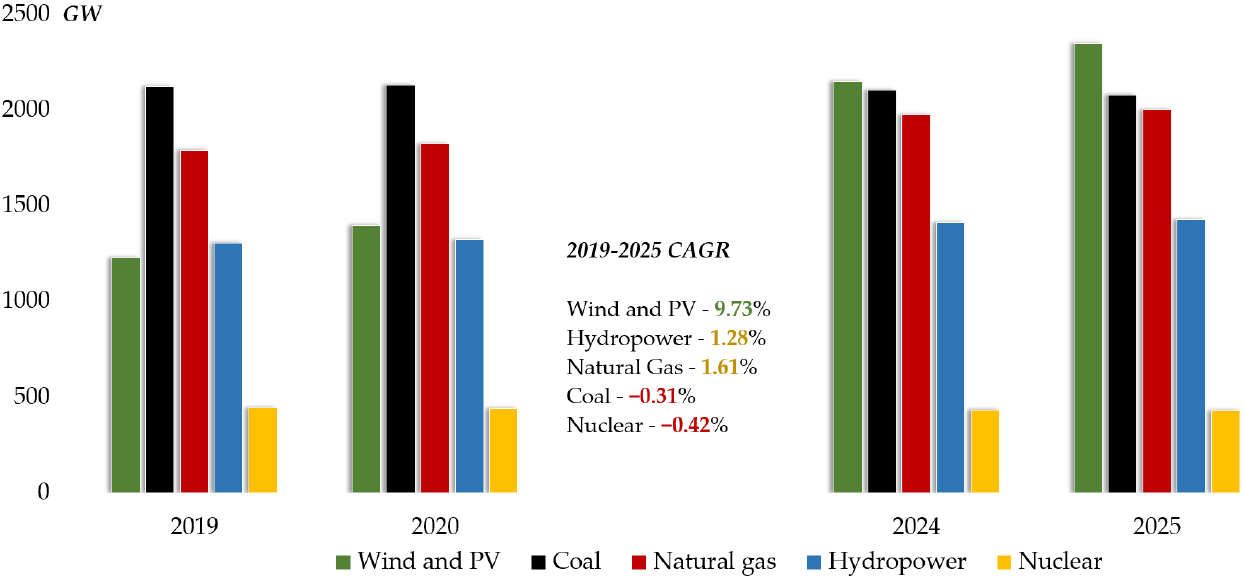
Figure 1. Forecast of the total electric capacity until 2025 according to International Energy Agency (IEA) analytical data [1].